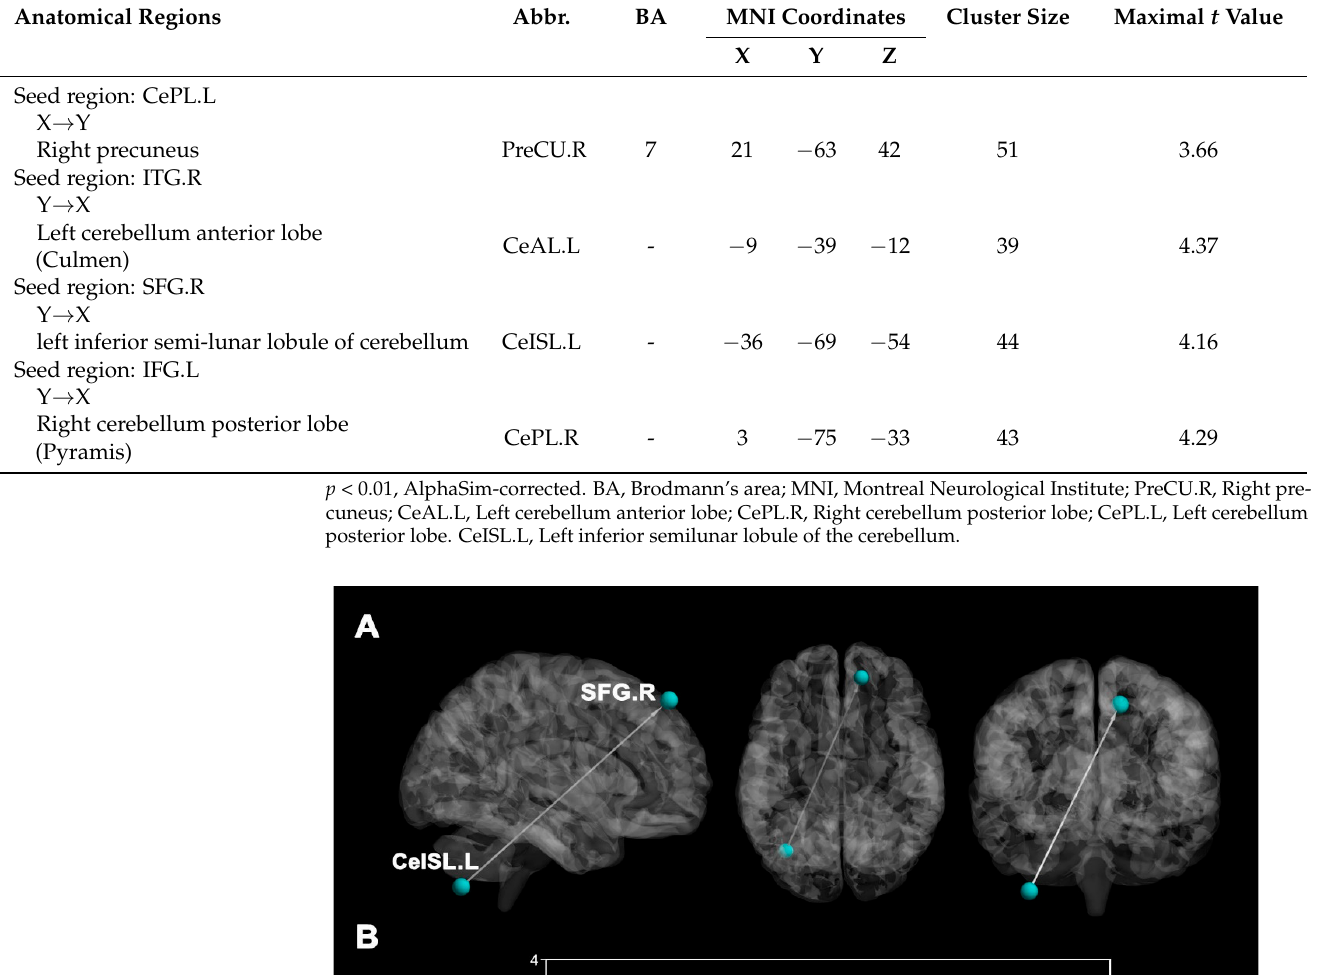
Table 3. Brain areas showing significant differences in EC between patients with JME and HCs.